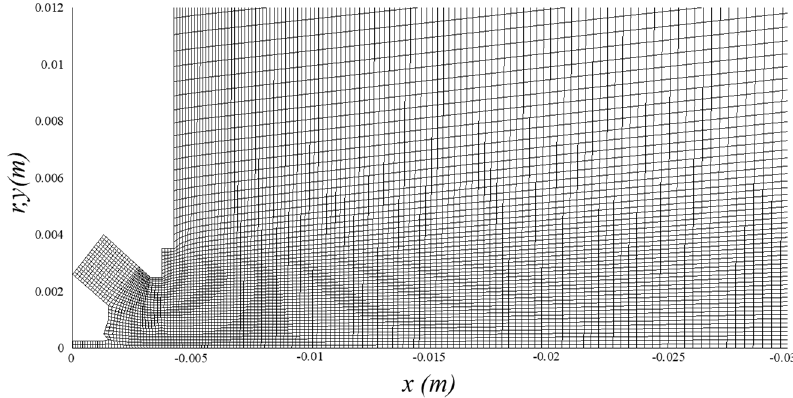
Figure 5. Close-up view of the computational grid of the Simplex atomizer.